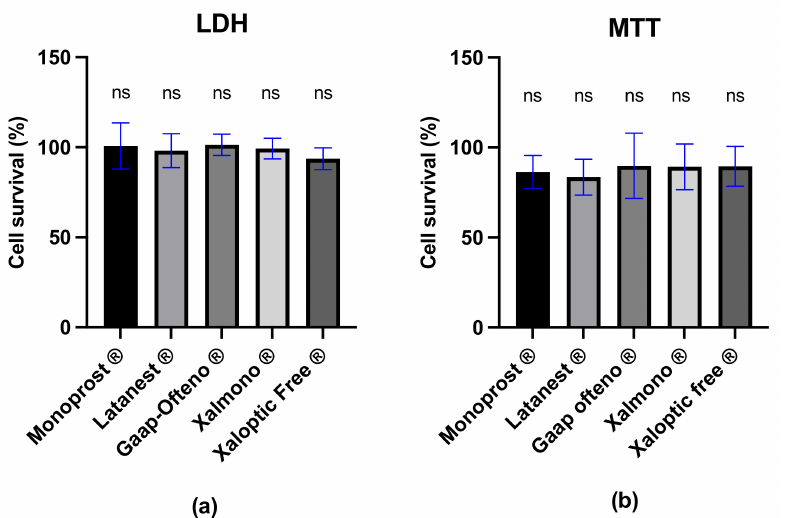
Figure 4. Mean cell survival analysis of human conjunctival goblet cells in % ± SD, relative to control, after 30 min of treatment with preservative-free 0.005% latanoprost eye drops. ( a ) Cell survival, examined with the LDH assay; ( b ) cell survival, examined with the MTT assay. Goblet cells were treated with diluted (1:7, v / v ) preservative-free 0.005% latanoprost products: Monoprost ® , Latanest ® , Gaap Ofteno ® , Xalmono ® , and Xaloptic ® Free. A one-way ANOVA with a Tukey multiple- comparison test was performed ( p = 0.05), n ≥ 4; ns = not significant; p ≥ 0.05.